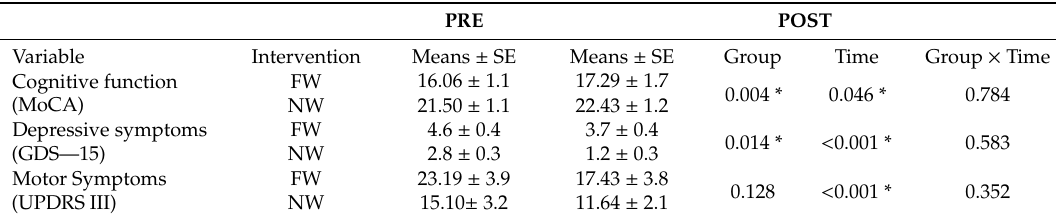
Table 3. Means and standard error to cognitive function, depressive symptoms, motor symptoms of disease for nordic and free walking groups in two di ff erent